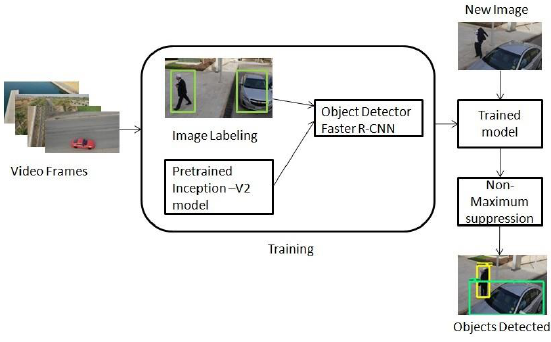
Figure 2. Architecture of multiple object